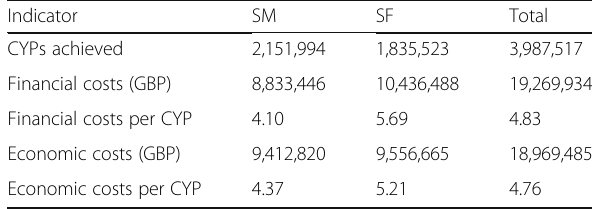
Table 3 Cost per CYP in